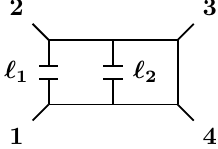
Figure 8 . One of the ways of decomposing a planar double-box diagram in terms of tree-level diagrams with n + 4 external legs. The dots on the left part denote three ways of placing one loop momentum (say ‘ 1 ), which leads to the three diagrams on the right-hand side, whereas the dot in the middle denotes the other loop momentum.